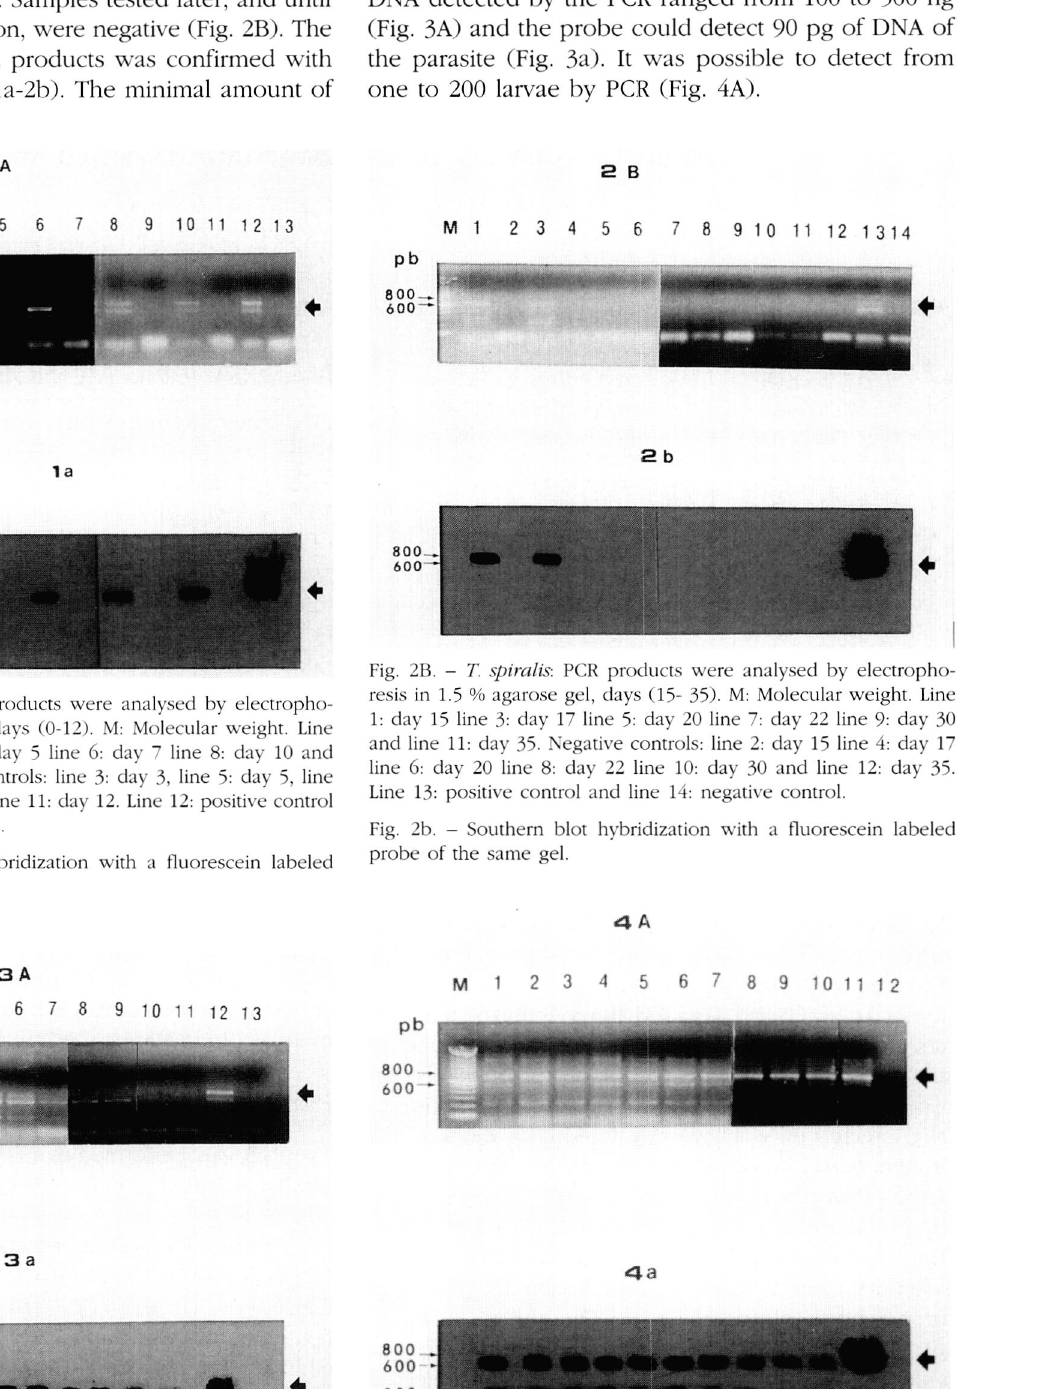
Fig. 4A. - T. spiralis. PCR products were analysed by electrophoresis in 1.5 % agarose gel. M: Molecular weight. Line 1: 200 larvae; line 2: 100 larvae; line 3: 80 larvae; line 4: 70 larvae; line 5: 60 larvae; line 6: 50 larvae; line 7: 20 larvae; line 8: 10 larvae; line 9: 5 larvae; line 10: 1 larvae. Line 11: Positive control and line 12: negative control. Fig. 4a. - Southern blot hybridization with a fluorescein labeled probe of the same